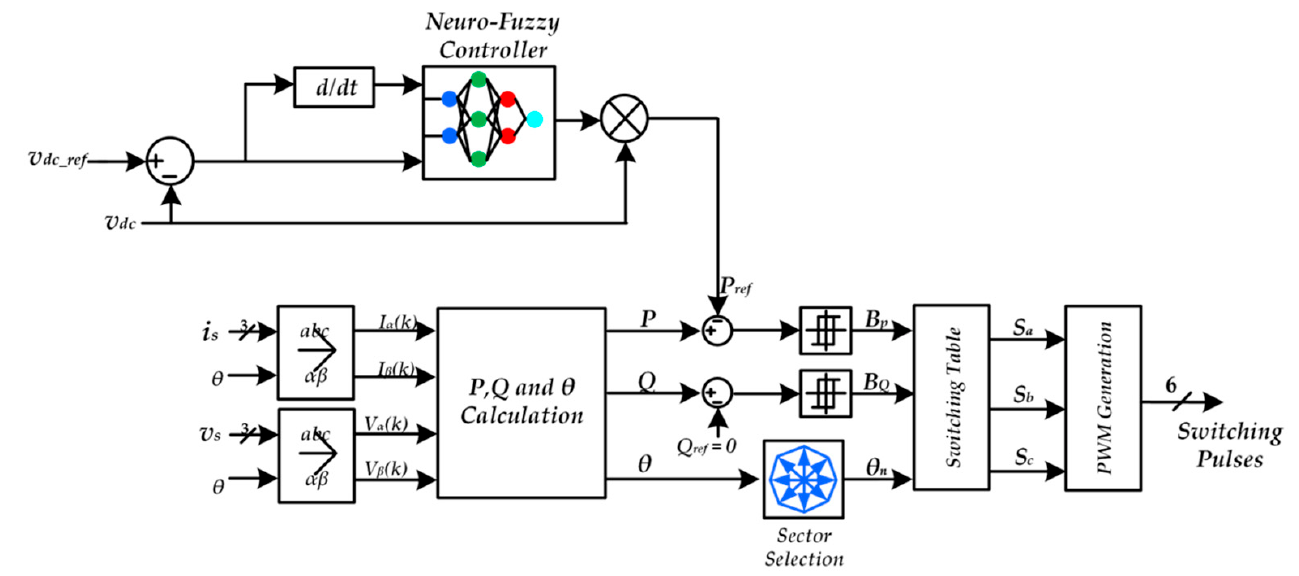
Figure 28. ANN based Control Strategy for EV battery Charging/Discharging. Table 4. Performance comparison of different control strategies for EV battery charging/discharg- ing.